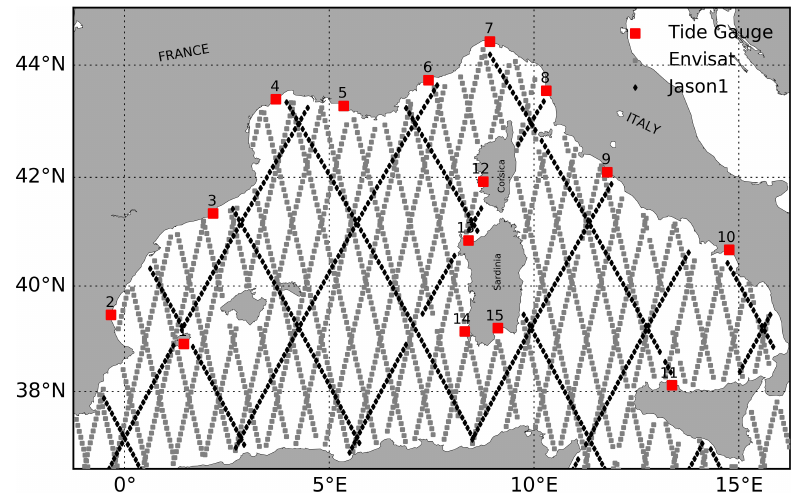
Figure 2. Locations of tide gauge (red squares) in the west Mediterranean Sea and the map of Envisat track (black square line) and Jason-1 track (gray square